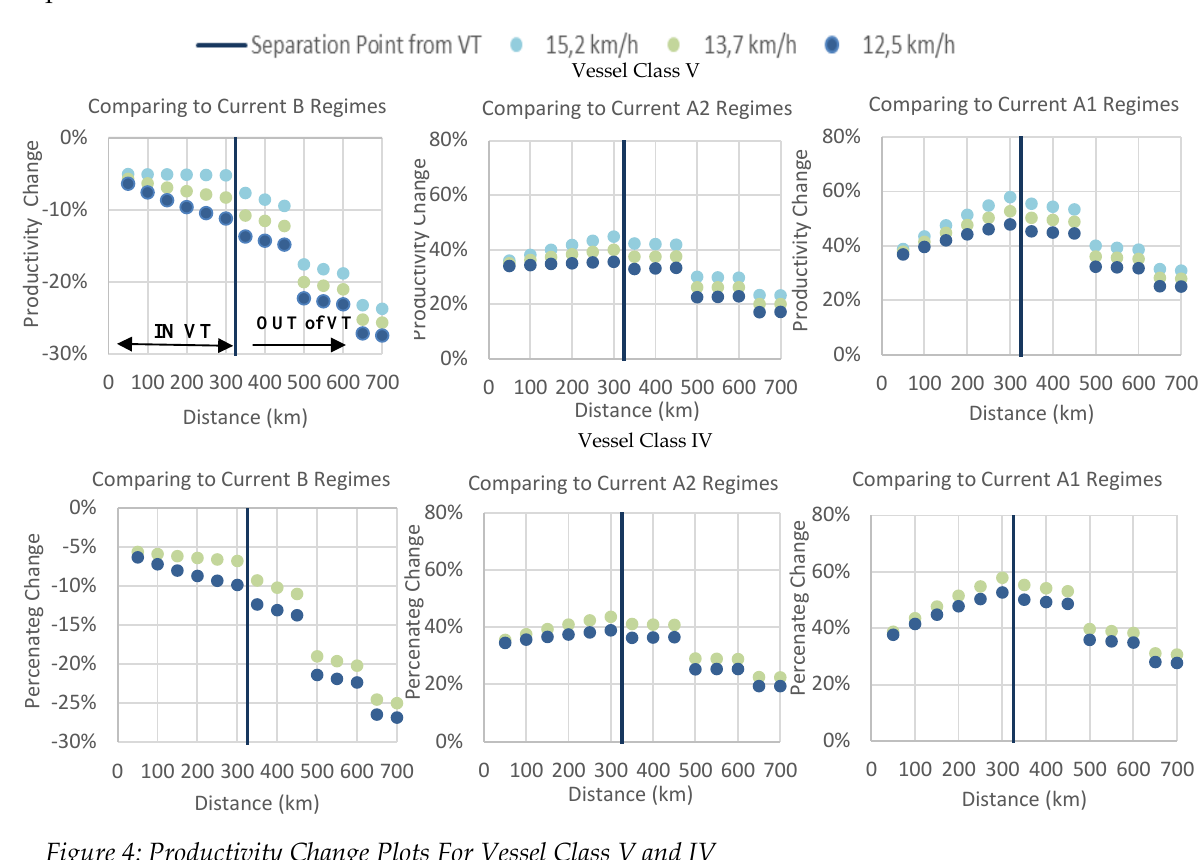
Figure 4: Productivity Change Plots For Vessel Class V and IV